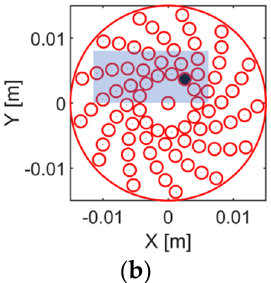
Figure 8. Cross-talk contours for ( a ) the CECAT and ( b ) the C1–3 when firing the first element in the 3 rd arm individually. The red circles represent the theoretical position of the neighbouring elements. 3.4. Pulse-Echo Response Characterisation of the transducer sensitivity (amplitude), bandwidth and pulse length were achieved using a pulse-echo test. A glass block was placed at the bottom of a tank, working as a reflector. The front surface of the transducer was positioned such that it was oriented in parallel to the glass block, with a separation distance of approximately 105 mm. The transducer was connected to a phased array controller, FIToolbox (Diagnostic Sonar Ltd., UK), and a 2 MHz half-cycle sine wave with 80 V amplitude was generated from the FIToolbox to drive each array element. The first received echo was recorded and analysed to extract performance metrics for each transducer. Pulse-echo responses were successfully acquired from all 79 array elements from the C1–3, with three array elements from the CECAT failing to record a satisfactory response. Figure 9 presents example pulse-echo responses and corresponding spectra of the centre element from the CECAT and the C1–3. Table 4 lists the average values of central frequency, − 20 dB pulse length, bandwidth and 𝑉 (cid:3043)(cid:3043) for all the working array elements in each transducer. The centre frequency is 1.95 MHz for the